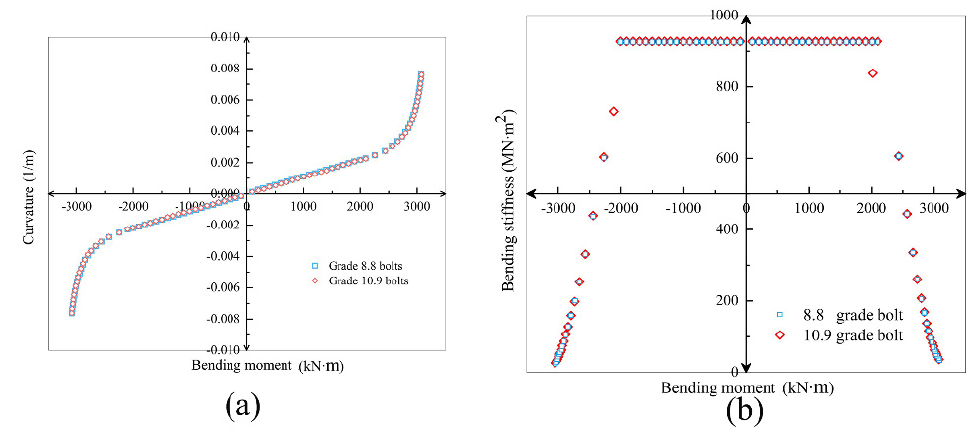
Figure 20. Comparison of M– ϕ ( a ) and K θ – ϕ ( b ) curves of grade 8.8 and 10.9 bolts ( N = 20,000 kN).